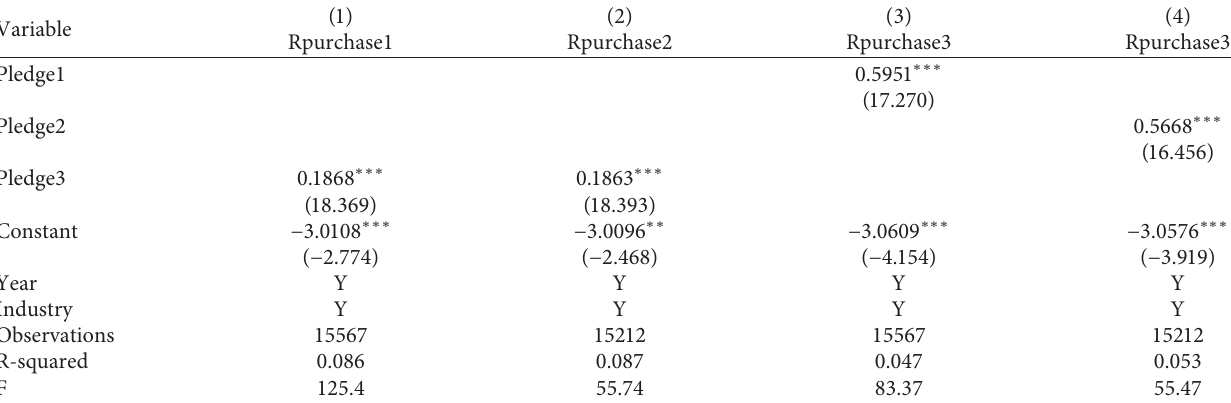
Table 6: Regression results of alternative explanatory variable and explained